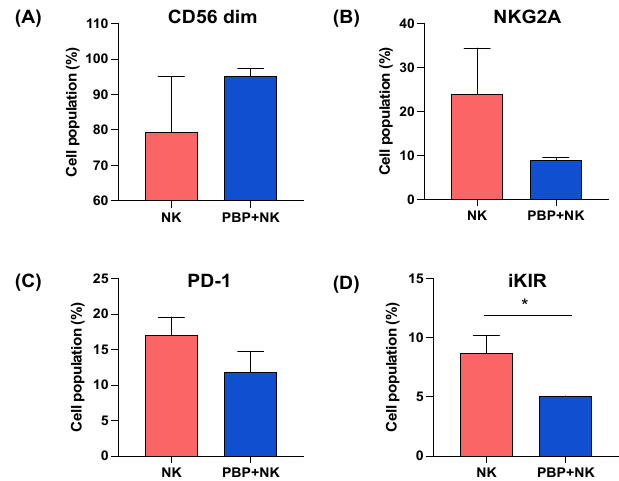
Figure 6. Phenotyping of NK cells isolated from tumor tissues: ( A ) population of CD56 dim NK cells, ( B – D ) populations expressing inhibitory receptors: NKG2A, PD-1, and inhibitory KIR (iKIR). NK cells were analyzed by gating CD56 positive cells from the total cell population. The bar graphs indicate the proportion of cells in the populations defined by the selection bars on the histograms shown in Figure S6. Statistical analysis was performed using the t-test, * p < 0.05.